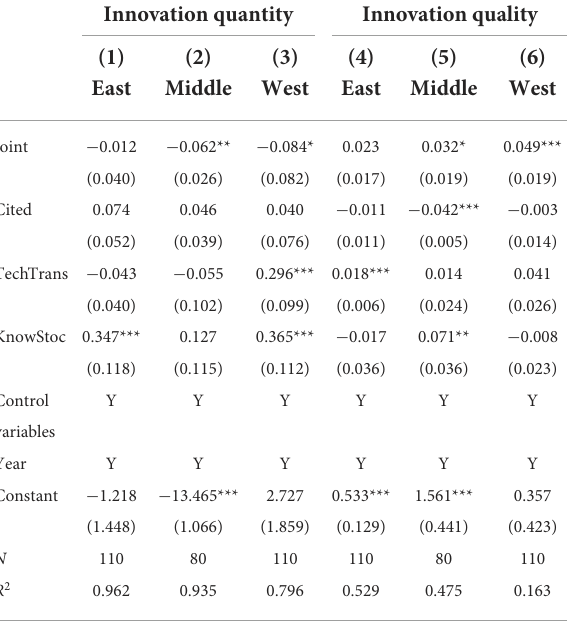
TABLE 6 The heterogeneity analysis of regional